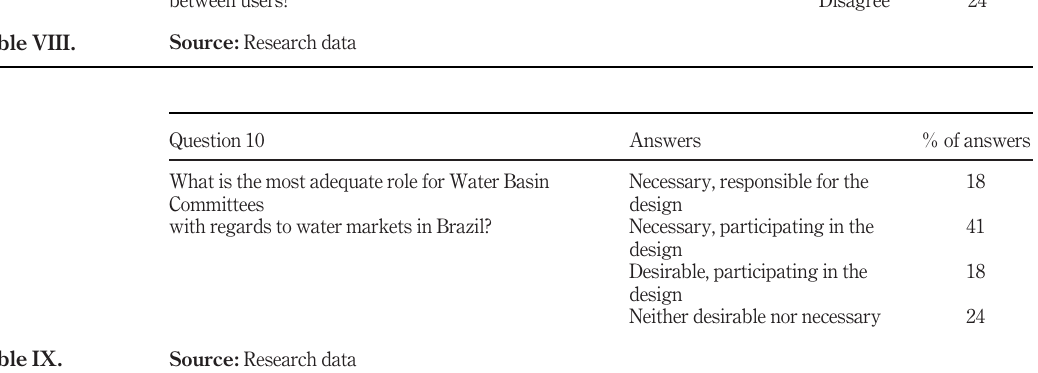
Agree 76 Disagree